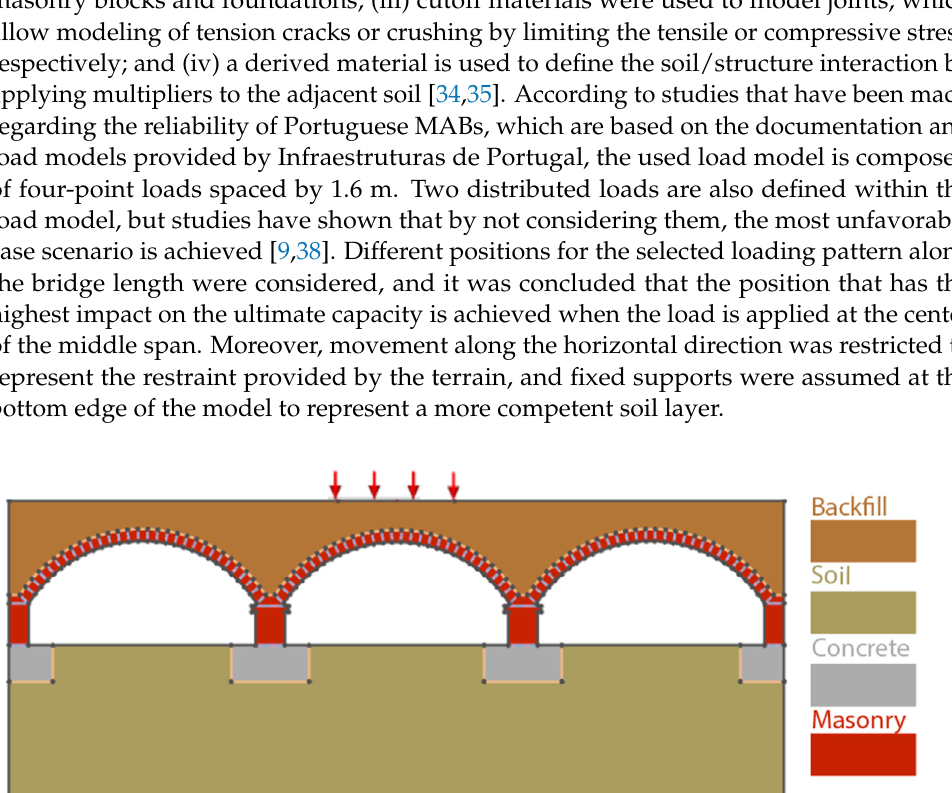
( b ) Figure 4. Stages of the scour depth when compared to the footing thickness ( 𝐹 (cid:3047) ) for the different scour scenarios: ( a ) symmetric; ( b ) asymmetric. The variables involved in the computation of scour depth are gathered; then, the ones considered random are introduced in the UQlab software, which was implemented using a script with its probabilistic distribution [27]. Next, the Monte Carlo sampling method is